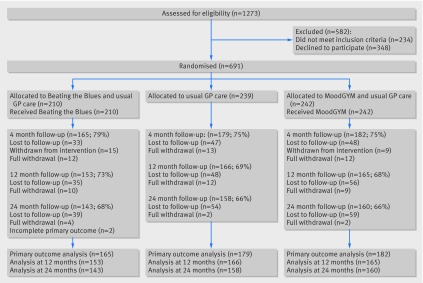
Fig 1 Selection, randomisation, and flow of participants through trial of computerised cognitive behaviour therapy for depression in primary care